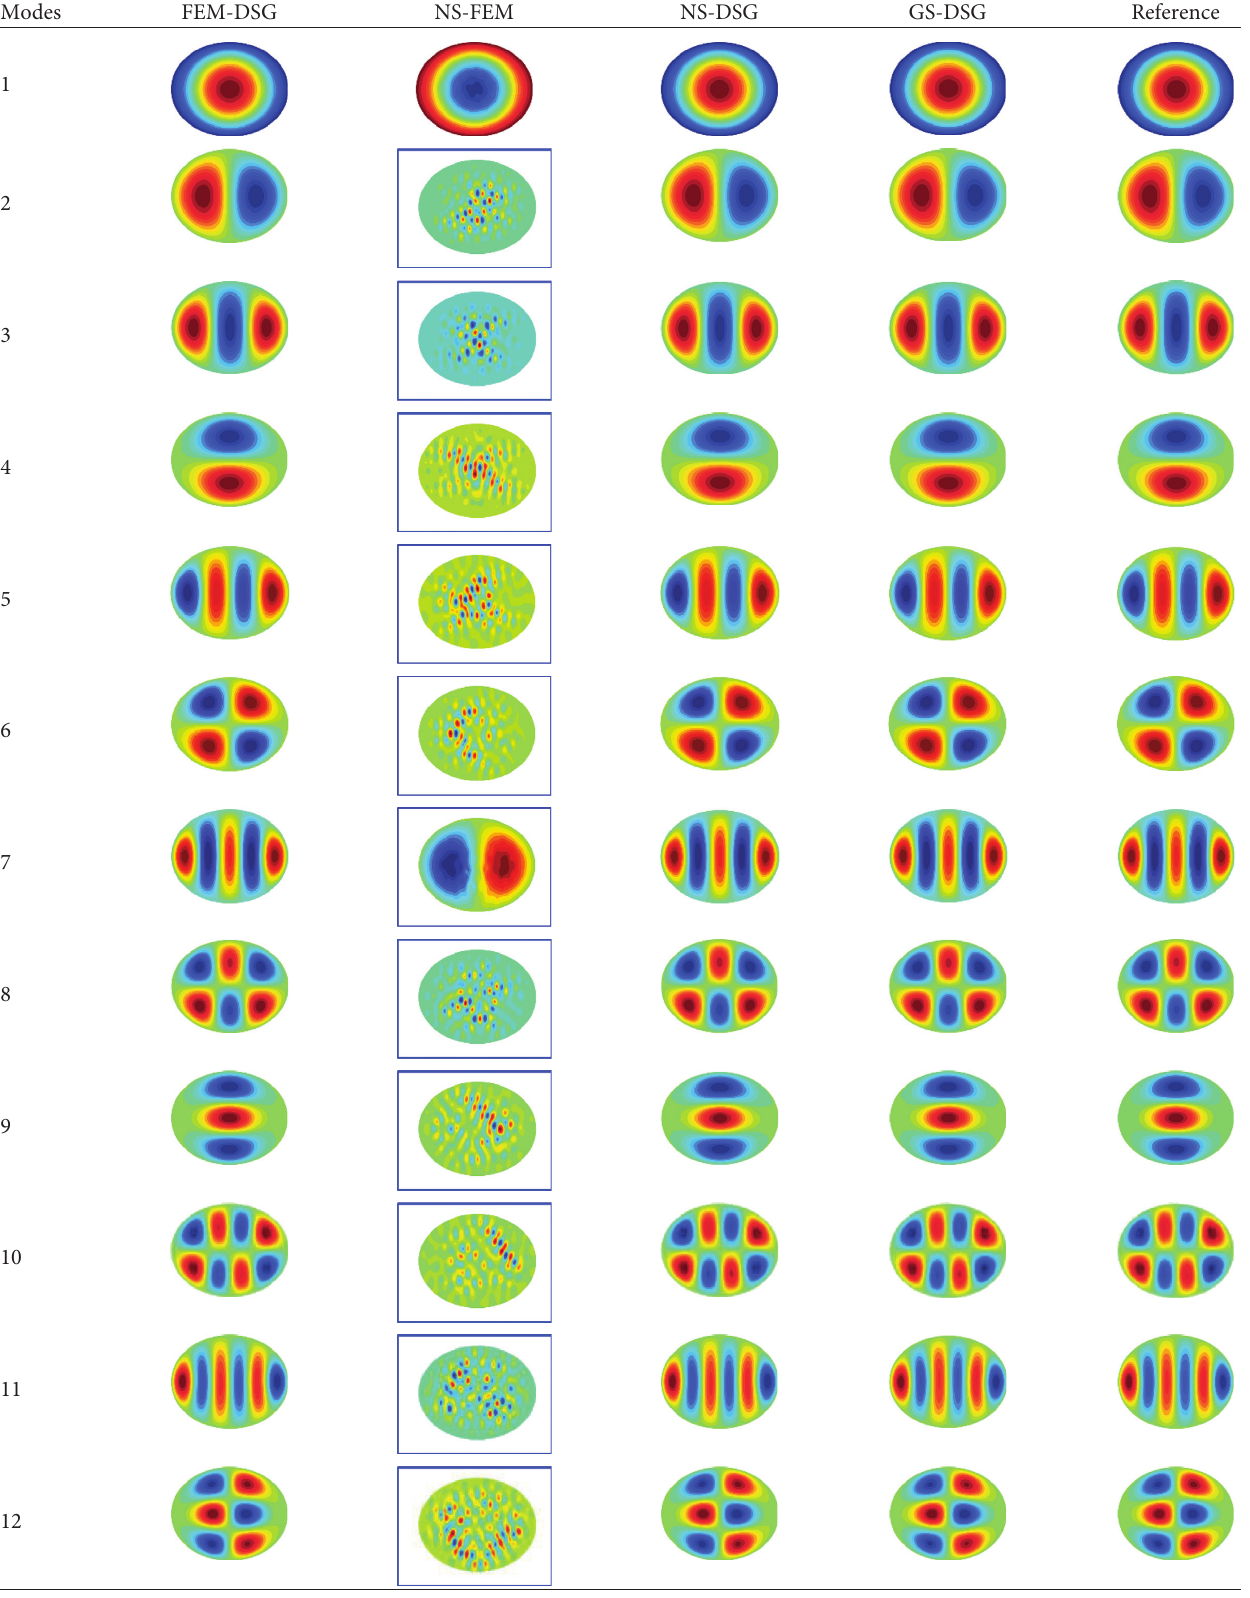
Table 7: First modes of the elliptical plate solved by different